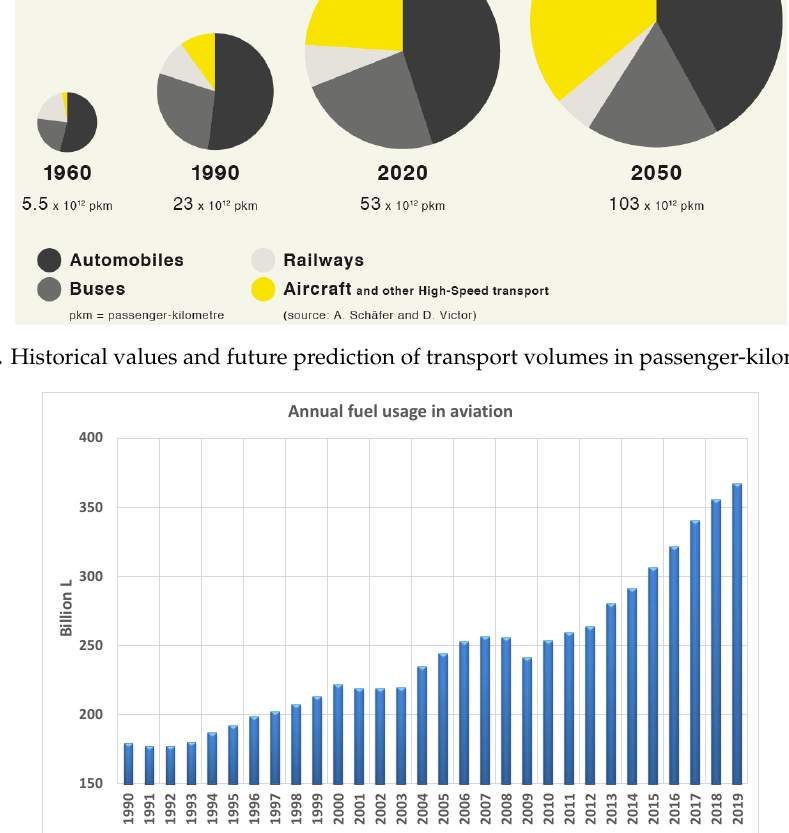
Figure 1. Historical values and future prediction of transport volumes in passenger-kilometers [6].